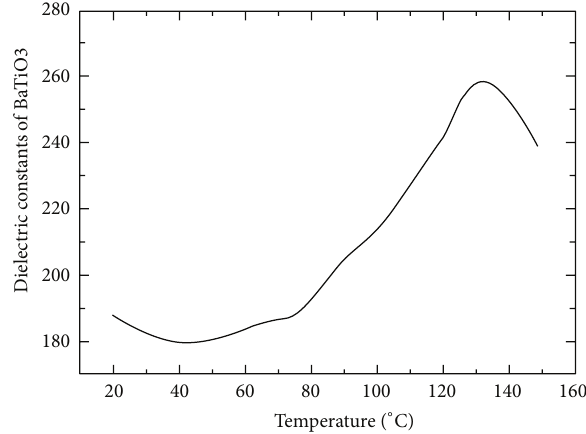
Figure 1: Variation of the dielectric constant of BaTiO3 versus the temperature